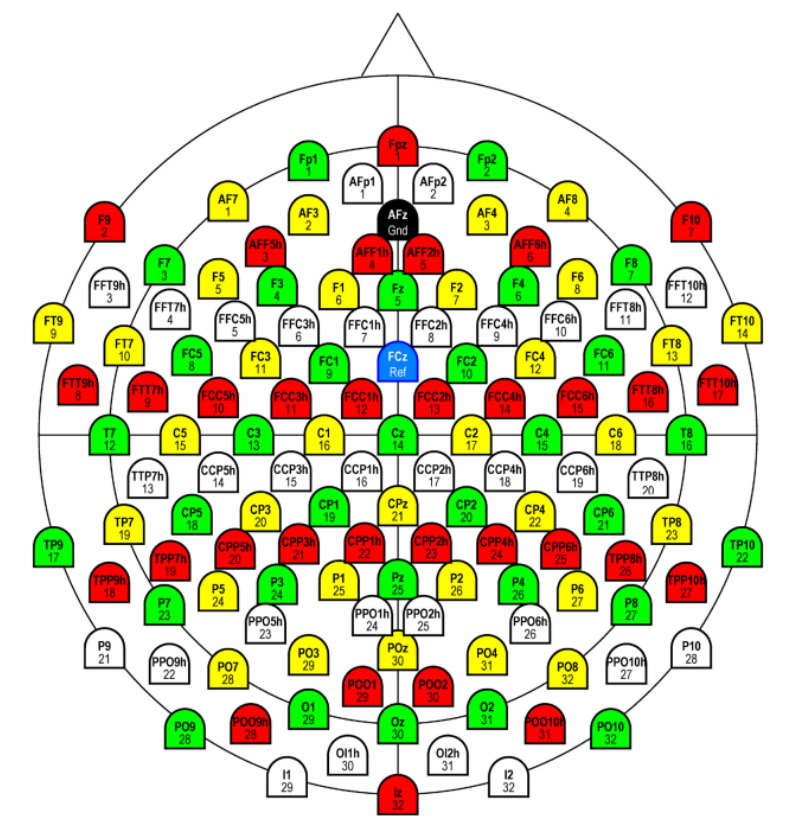
Figure 1. ActiCAP128 standard-2: EEG channel placement; each channel in this figure is identified by a prefix letter referring to brain cortex (Fp: frontal, T: temporal, C: central, P: parietal, O: occipital) and a number indicating the electrode